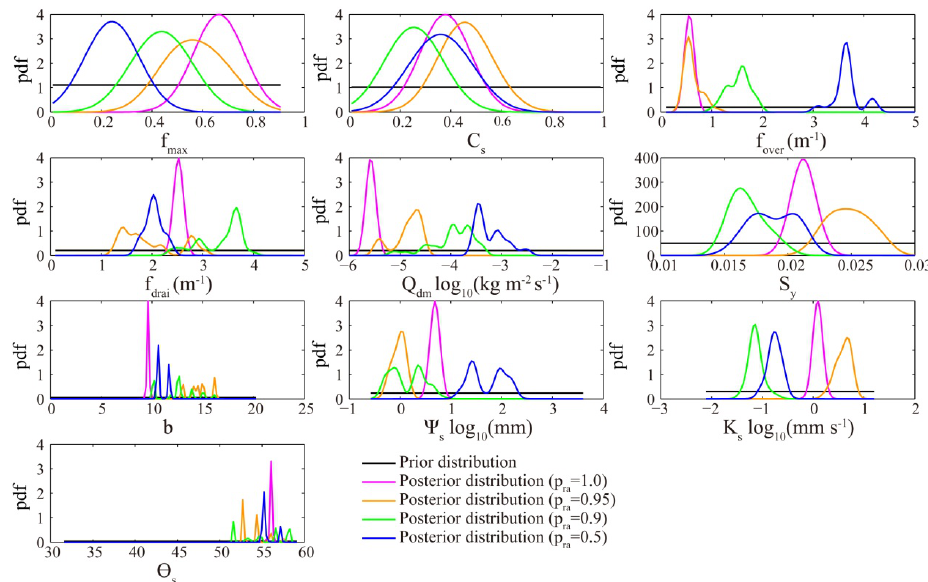
Figure 5. Posterior distribution of the parameters with four reference acceptance probabilities using daily heat flux data at the US-ARM site. 811 December, the posterior estimates with reference acceptance